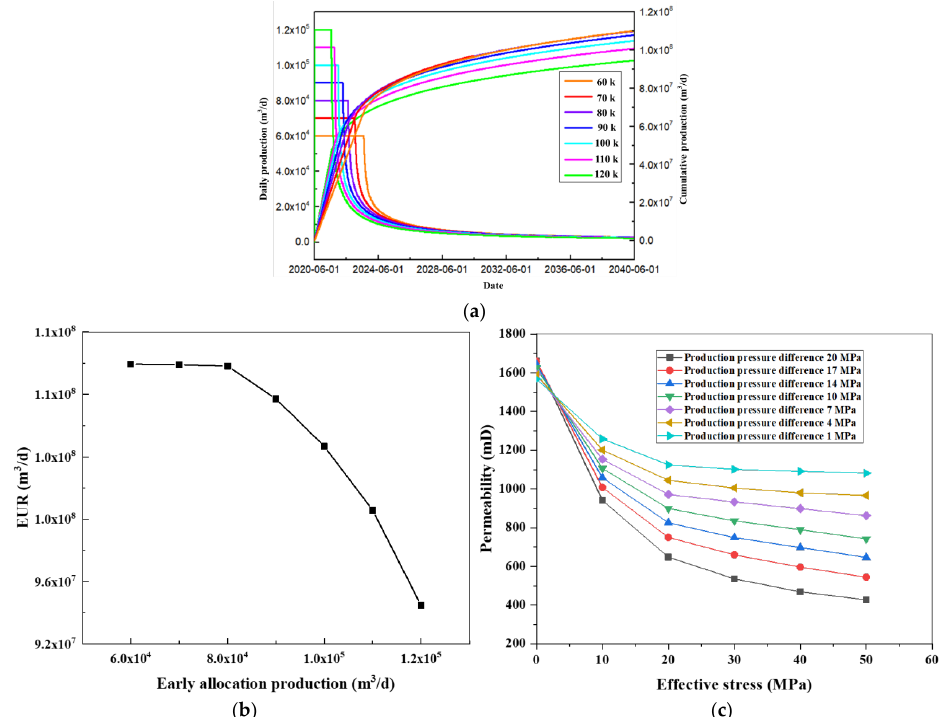
Figure 14. The change in cumulative production, EUR, and effective stress under different allocation production and permeability: ( a ) the 20 years of cumulative production; ( b ) the change of EUR; ( c )